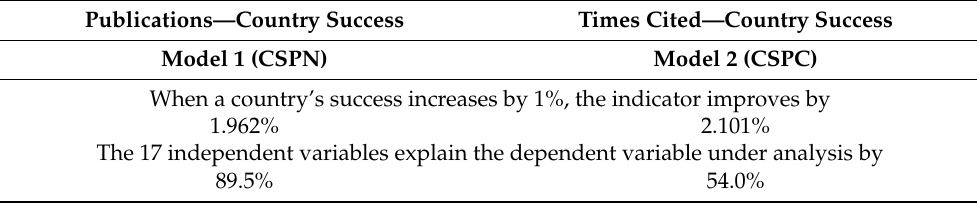
Table 8. How country success and its factors influence the two